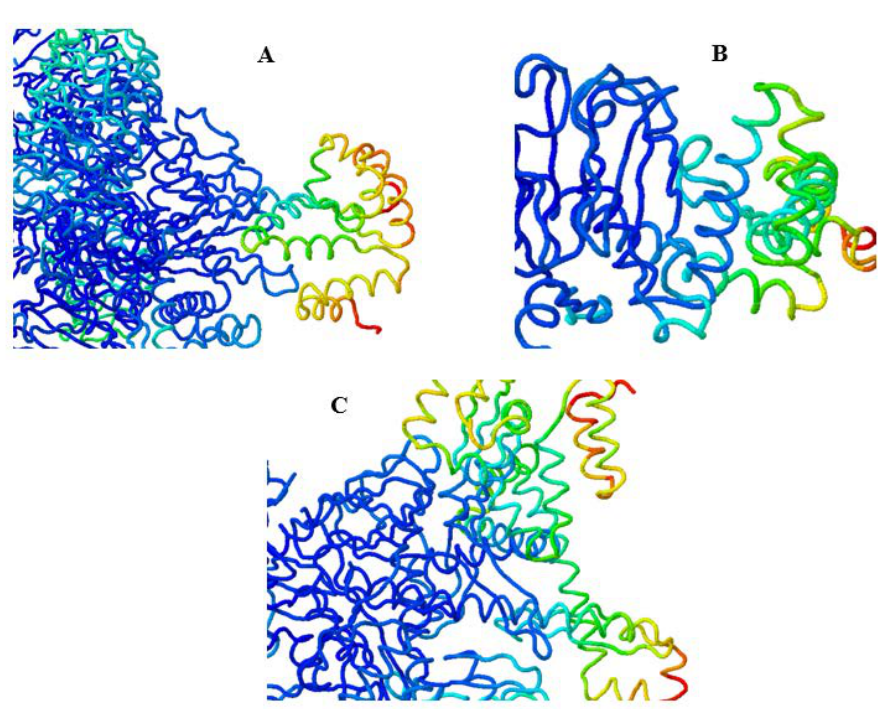
Figure 8. ( A ) MD simulations of vaccine and GRP78, ( B ) MD simulations of vaccine and MHC-I, ( C ) MD simulations of vaccine and TLR2.